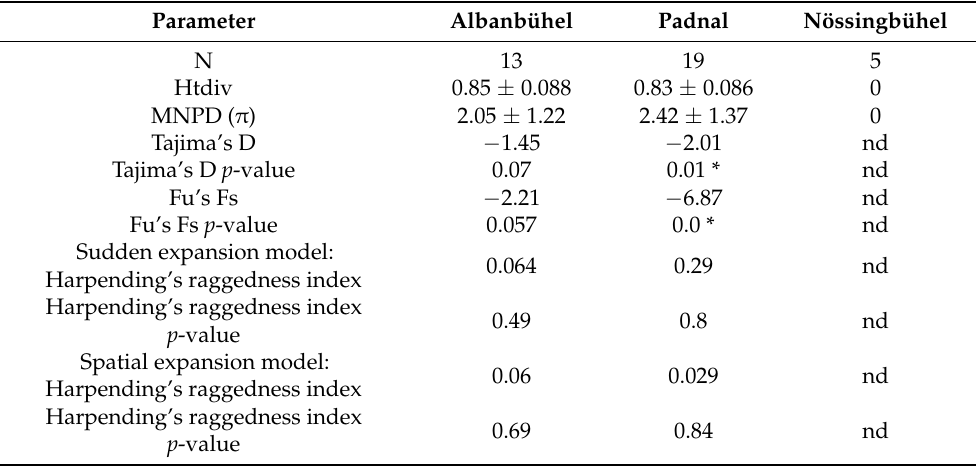
Table 2. Population diversity measures and demographic statistics from the sites Albanbühel, Savognin Padnal, and Nössingbühel. * denotes significant P values on 0.05 level. Parameter Albanbühel Padnal Nössingbühel N 13 19 5 Htdiv 0.85 ± 0.088 0.83 ± 0.086 0 2.05 ± 1.22 2.42 ± 1.37